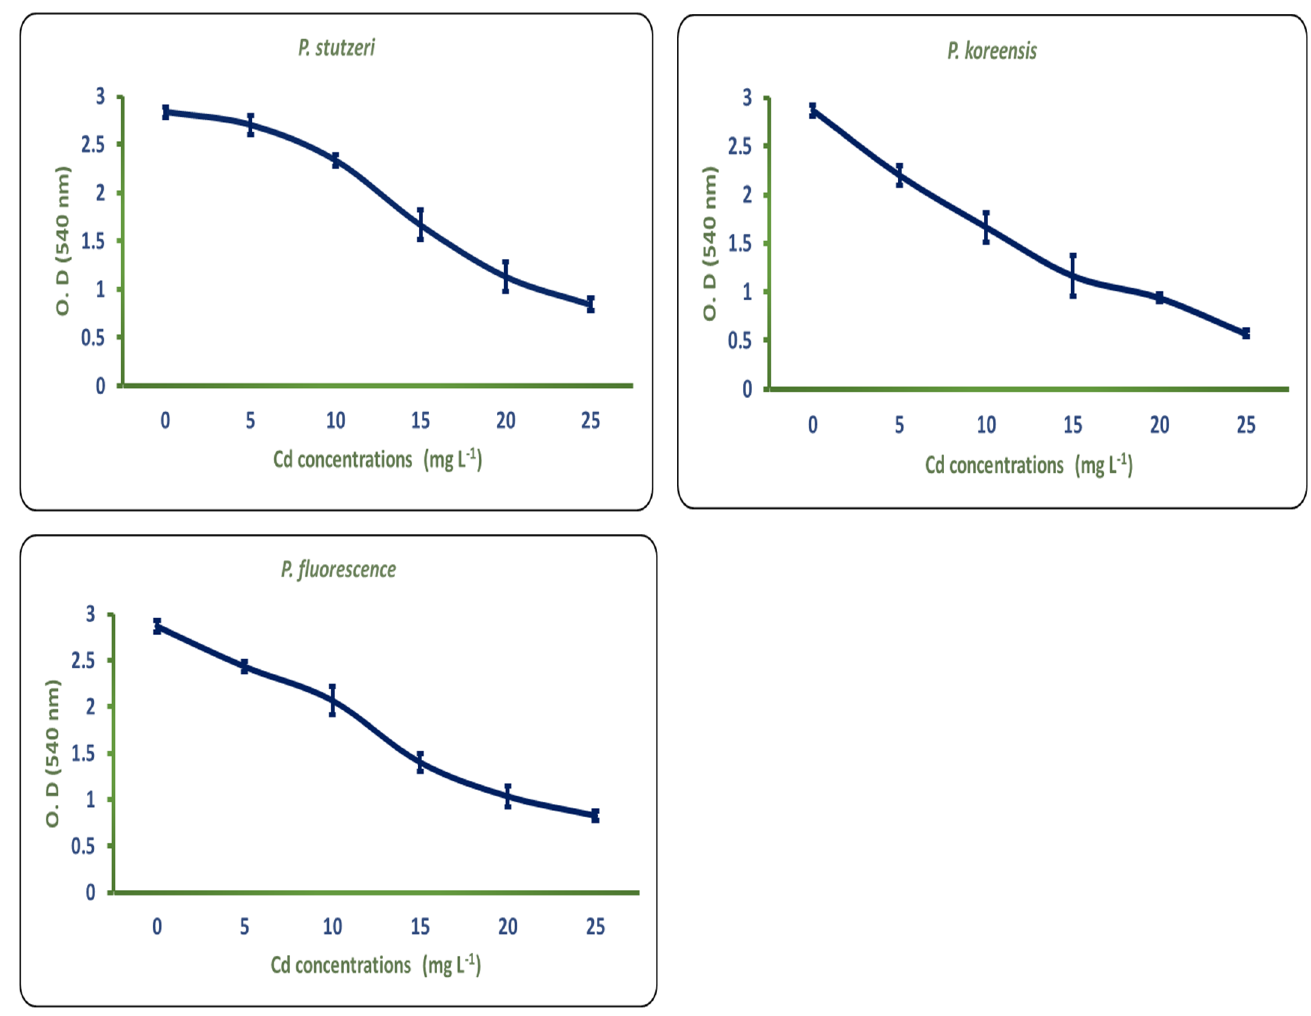
Figure 1. Growth pattern of Pseudomonas strains in the absence (0 Cd) and presence of different concentrations (0, 5, 10, 15, 20, and 25 mg L − 1 ) of Cd.